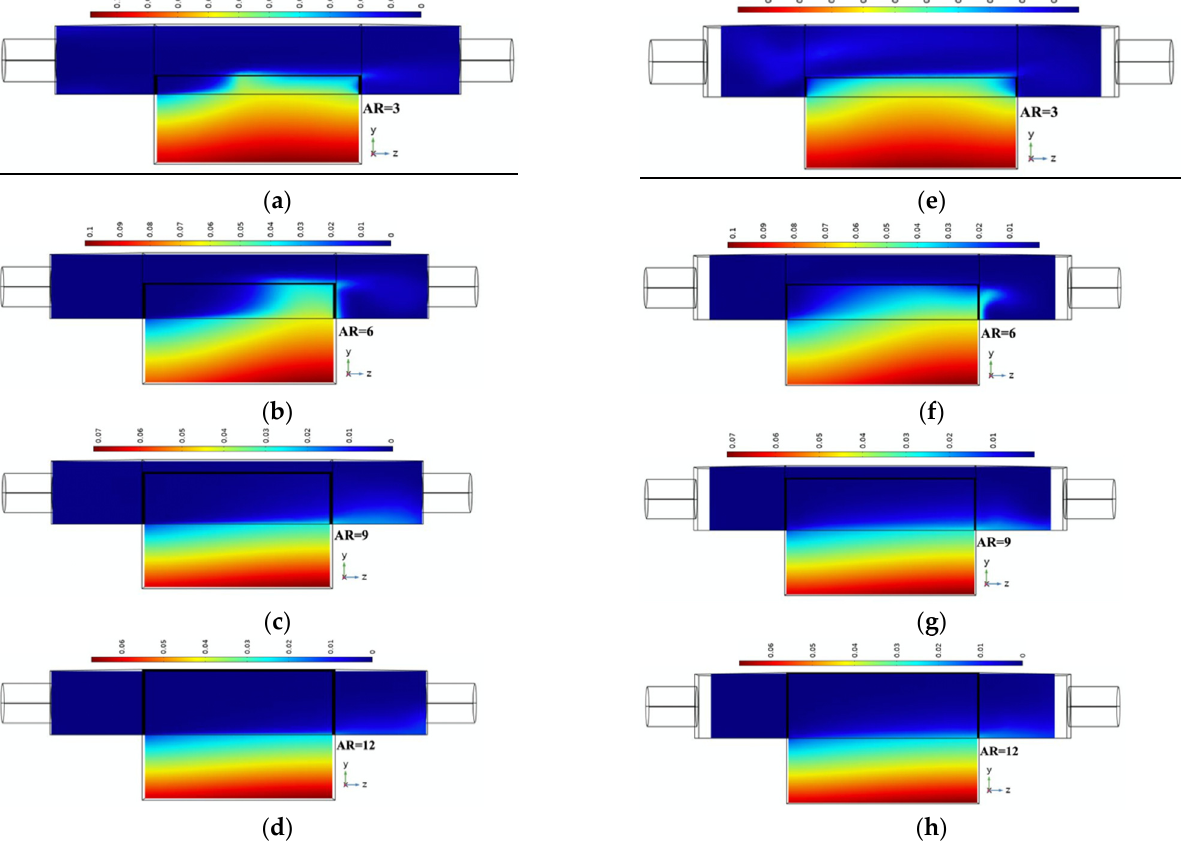
(12) Figure 9. Friction factor for all cases.